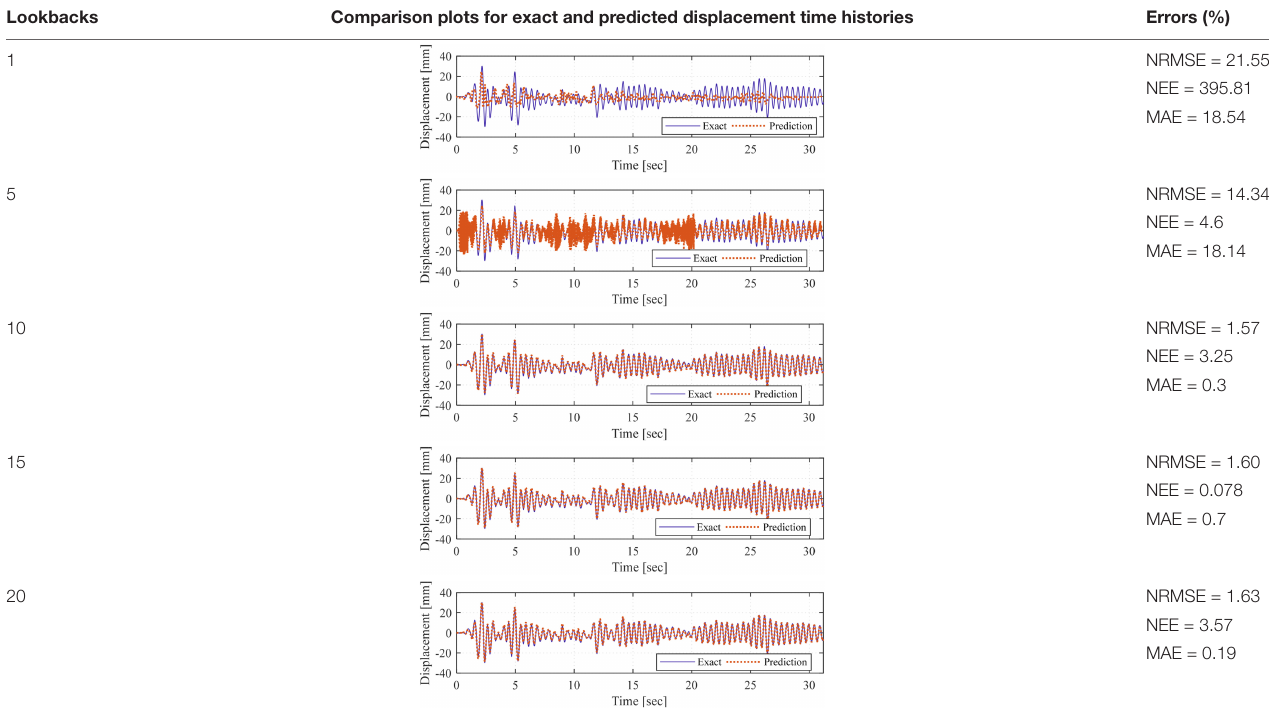
TABLE 2 | Deep LSTM model comparison for different lookback values. Lookbacks Comparison plots for exact and predicted displacement time